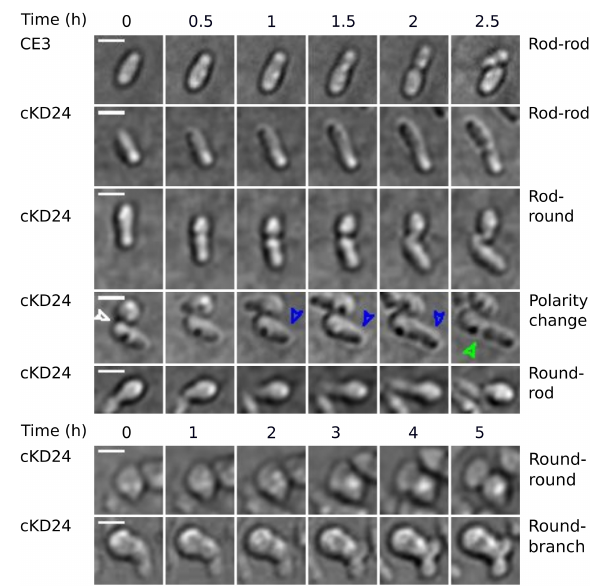
FIGURE 2 | Depletion of RdsA provokes changes in cell division. Each row shows representative sequential images of time-lapse microscopical analysis of R. etli CE3 and cKD24 in absence of induction. Cells were grown in PY medium for 9 h and then spotted on agarose pads (1% in MMY medium). Cells were imaged every 10 min using DIC microscopy. For each block, time is shown at the top. On the right part, the type of change detected is indicated. In each row, the zero time corresponds to the beginning of the time-lapse experiment except for the cKD24 rows: polarity change, round-rod, and round-round where the zero time corresponds to cells imaged after 1:20 h, 30 min, and 2:30 h of growth, respectively. Recording times were chosen to optimize detection of each phenotype. In the row corresponding to polarity change in the cKD24 mutant, the first photograph shows the end of the cell division in a round cell producing a rod cell. This allows us to locate the new pole in the rod-shaped cell (white arrow). The rod cell elongates through the old pole (blue arrow), which is usually inactivated for growth in wild-type cells, finally, the cell septation begins (green arrow). Scale bars, 2 µ m.